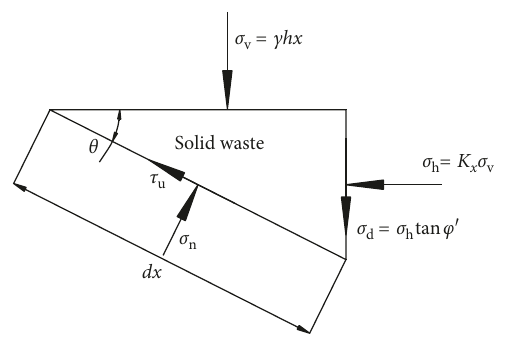
Figure 2: Force equilibrium analysis of a tailings